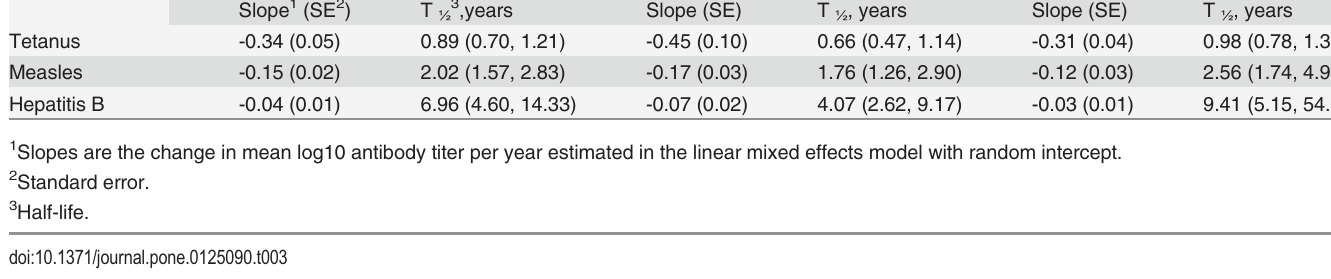
Table 3. Half-life estimates of vaccine-specific IgG levels overall and by age group. VaccineV